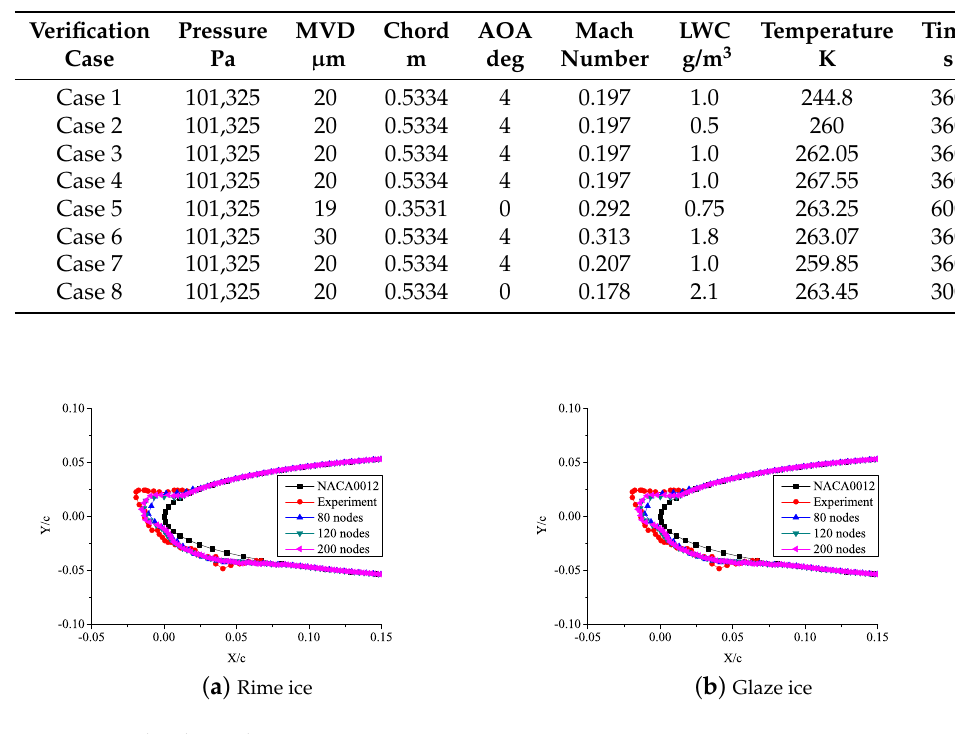
Figure 6. Grid independence